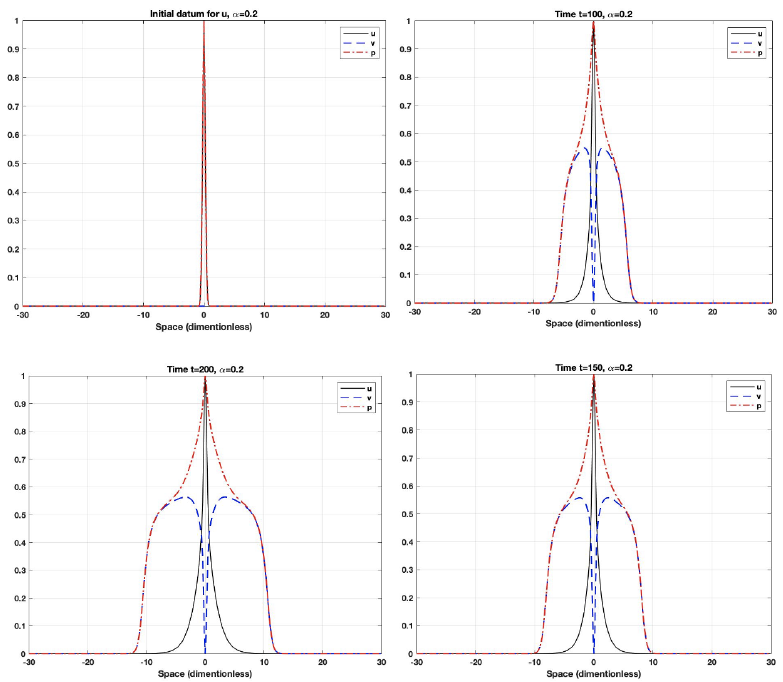
Figure 3. Distribution of CSCs (black), NSCCs (blue) and total tumour density (red). For high mortality rate of NSCCs ( α = 2 ) at various total times T ∈ { 0,100,150,200 } and fractional order of time derivative β =